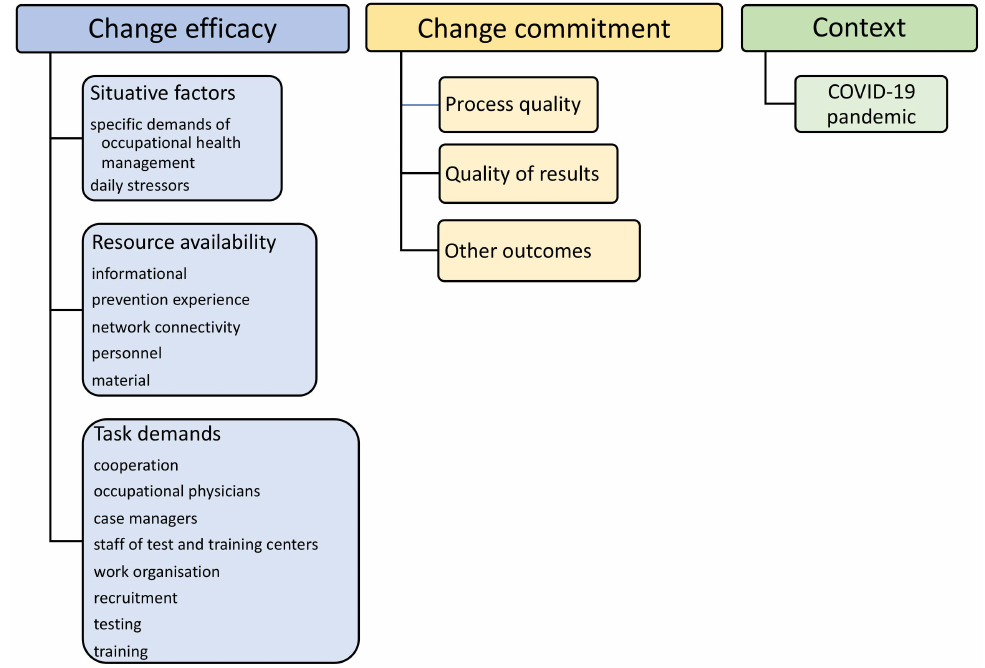
Figure 1. Coding